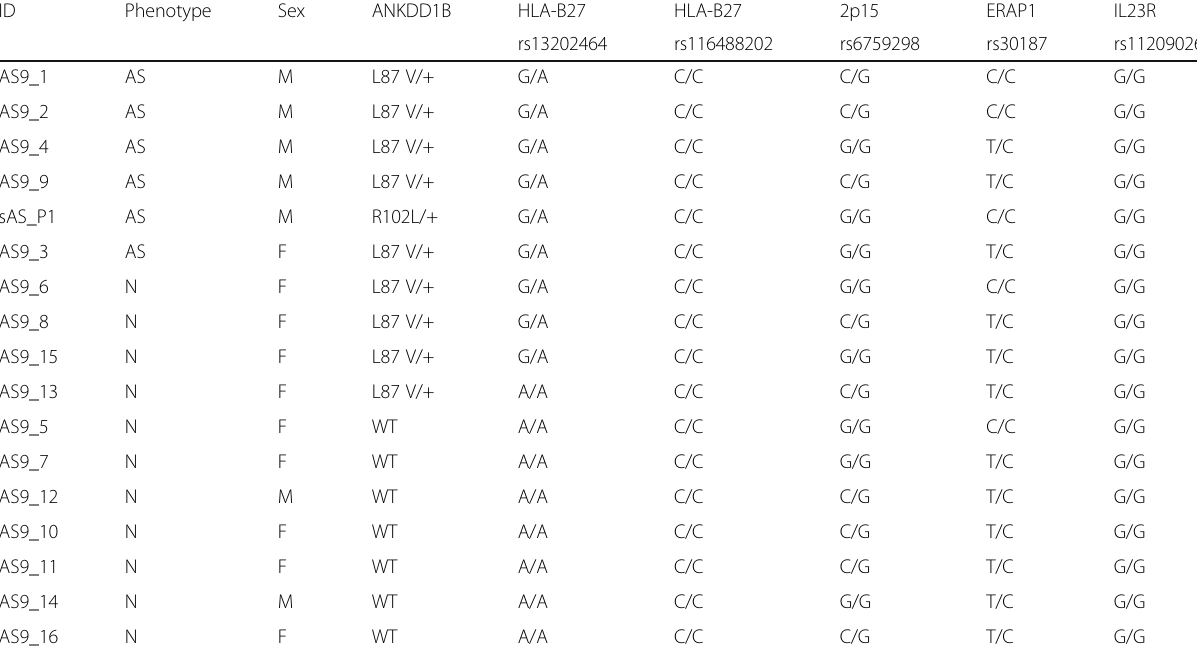
Table 1 Haplotype analysis of major AS risk loci on the study subjects